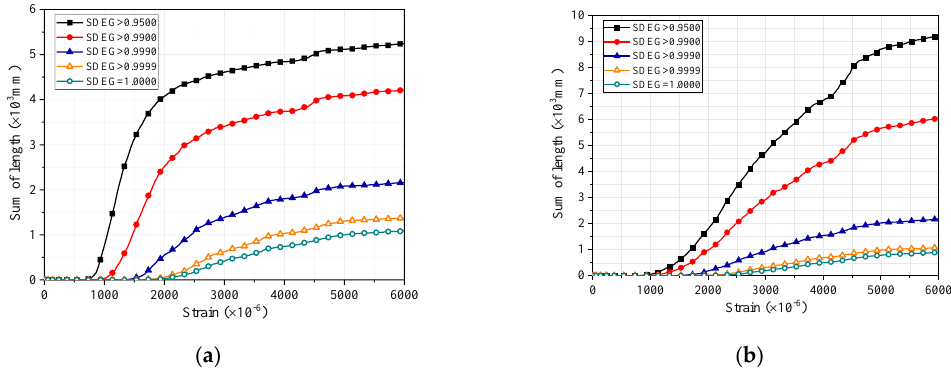
Figure 15. The relationship between global strain and the sum of length of ( a ) ITZ elements and ( b ) MII elements with different damage degree.